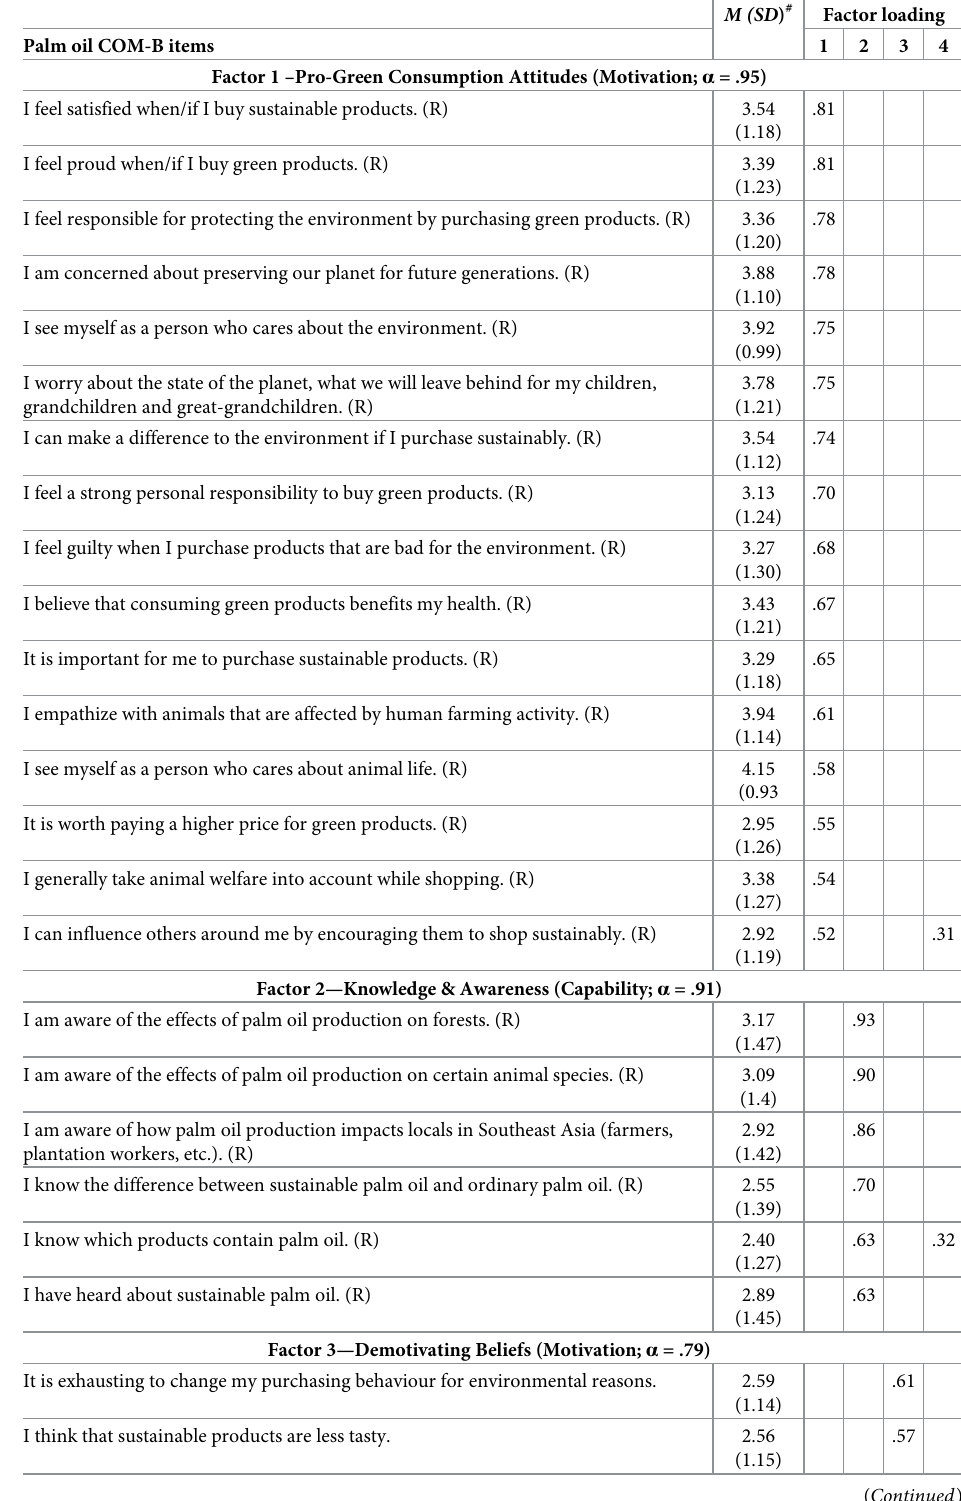
Table 2. Exploratory factor analysis pattern matrix loadings (N =